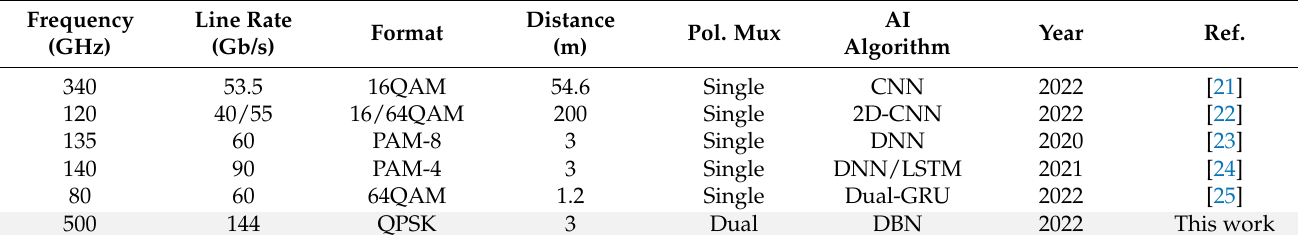
Table 1. Summary of photonics-aided wireless transmission systems based on AI